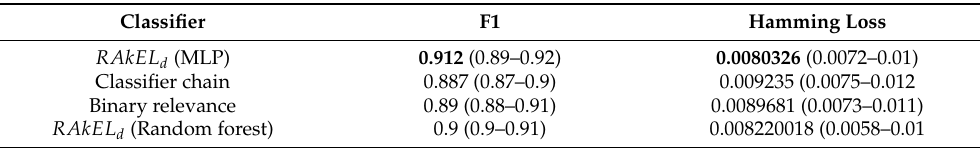
Table 11. Average F1 score & Hamming loss per classifier (CASAS dataset). Inside the parentheses is the confidence interval (96% confidence). Best values can be seen in bold.